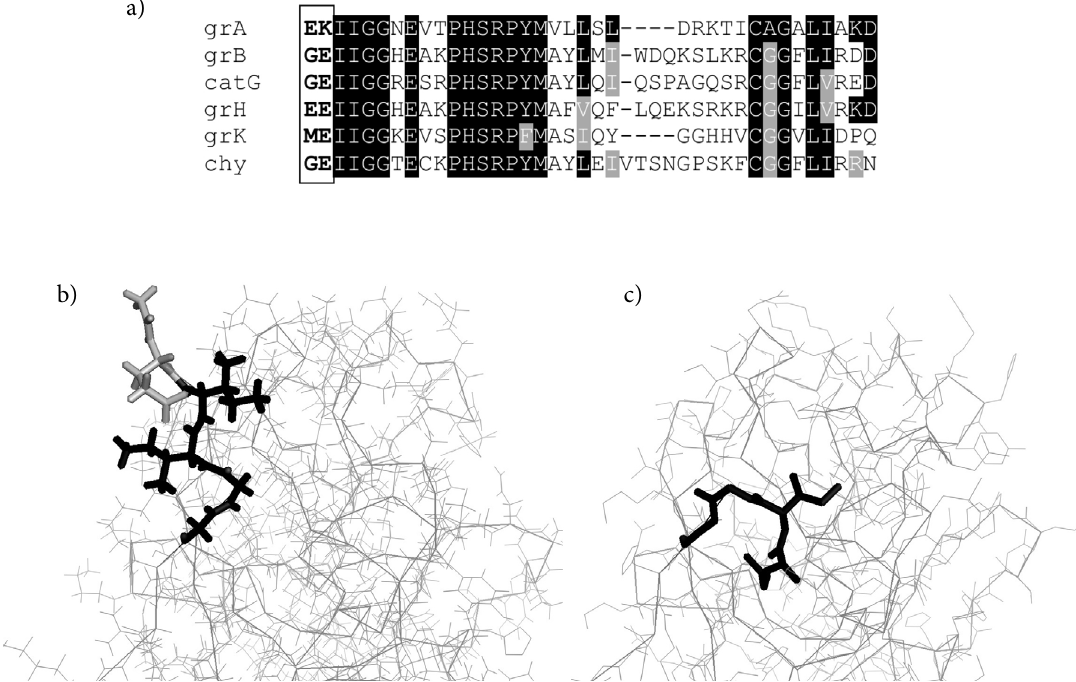
Figure 6. Prodipeptides of granzymes A and B, together with highly similar N-terminal parts are preventing the activity of the granzymes. Following the removal of prodipeptide, the truncated enzyme undergoes structural rearrangement yielding an active enzyme. (a) Sequence alignment of N-ter- minal of human granzymes A, B, H, and K (grA, grB, grH, grK, respectively), cathepsin G (catG), and chymase (chy). Prodipeptides are marked by the box. Identical amino acids have a black background, and similar amino acids have a grey background. The alignment was performed using Clustal Omega, and shading was done using the BoxShade online service. (b, c) A comparison of modeled progranzyme B (b) with the structure of mature granzyme B (c) (PDB entry 1IAU). N-terminal residues of both molecules are marked with thicker lines. The prodipeptide of granzyme B, pointed out and accessible to cathepsin C, is marked by light gray. The N-terminal part of the reposition of the mature granzyme is